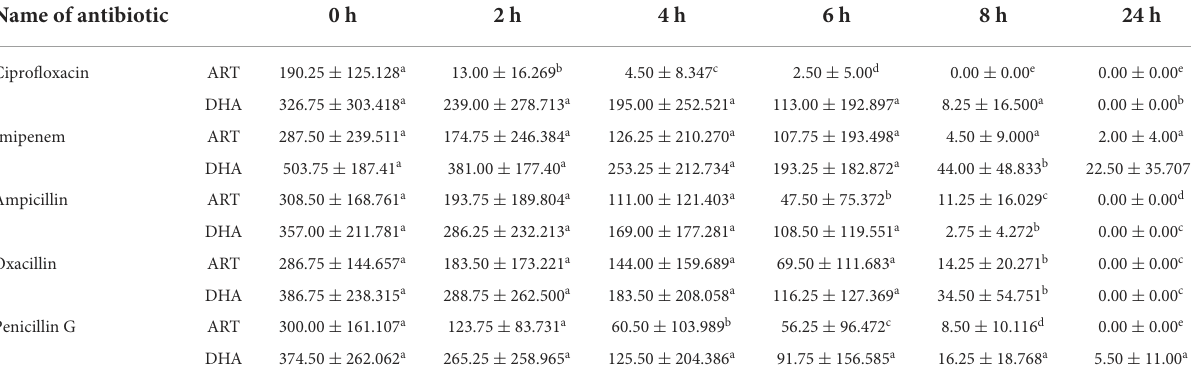
(Table 7). The first reduction in bacterial count (CFU/ml)